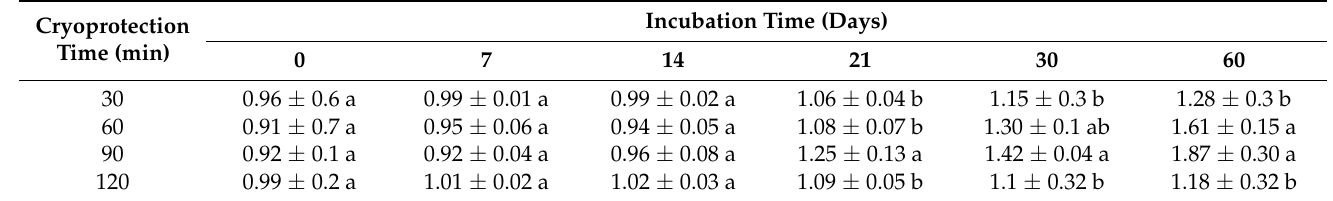
Table 8. Changes in the fresh weight of F. mandshurica embryogenic callus with culture under different cryoprotection